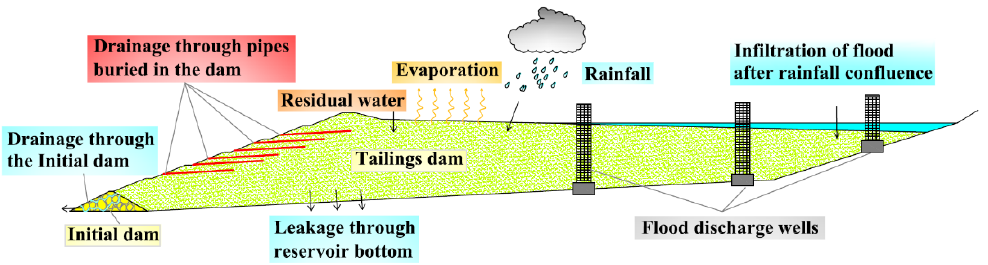
Figure 1. Diagram of the factors leading to the change of seepage water in the dry-stack tailings pond (Note: residual water refers to the water that cannot be separated freely after tailings are de- hydrated).